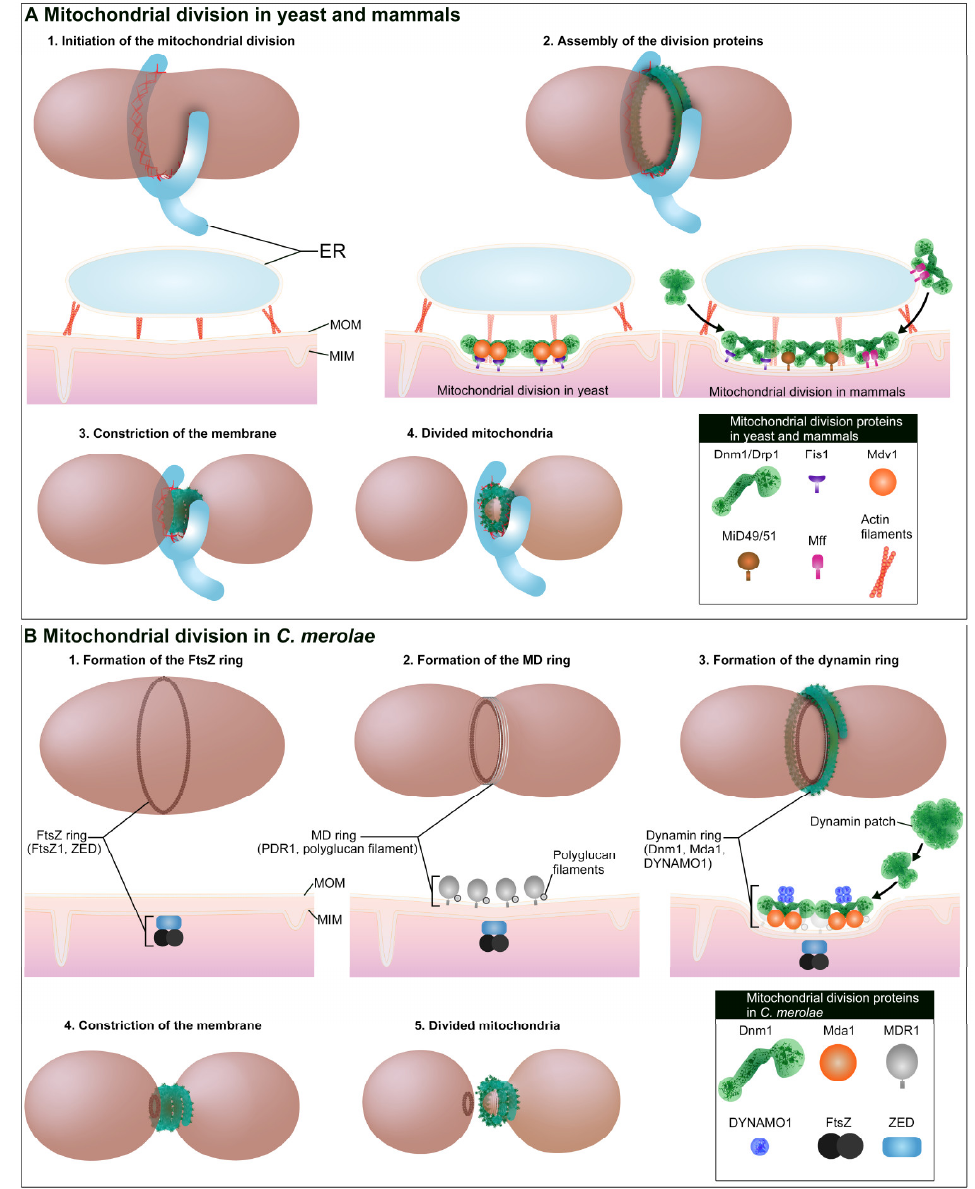
Figure 1. Mitochondria are divided by Dnm1/Drp1-based membrane fission machinery. Schematic images represent dividing mitochondria and their cross sections at the division plane. ( A ), Mitochondrial division in yeast and mammals is initiated at the endoplasmic reticulum (ER)-mitochondrion contact site. At the contact site, ER tubules encircle the mitochondria and polymerized actin is formed. Receptor proteins Fis1 and Mdv1/Caf4 are involved in the recruitment of Dnm1 to mitochondrial outer membrane (MOM) in yeast, while Fis1, Mff, and MiD49/51 are involved in the recruitment of Drp1 in mammals. In mammals, the ER–mitochondrion contact site also participates in the recruitment of Drp1. Polymerized Dnm1/Drp1 constricts and pinches off mitochondrial division site. ( B ) In C. merolae , a mitochondrion is divided by mitochondrion-dividing (MD) machinery (FtsZ ring, MD ring and dynamin ring). The first event of the mitochondrial division is formation of the FtsZ ring. ZED is important for the FtsZ ring formation on the matrix side of MIM followed by the formation of MD ring. MDR1 is involved in the formation of MD ring. Dynamin ring is composed of Dnm1, and Mdv1/Caf4 ortholog Mda1 is involved in the recruitment of Dnm1. Dnm1 is likely recruited from cytosolic dynamin patches. During the constriction of MD machinery, DYNAMO1 generates GTP and supports the GTPase activity of Dnm1.